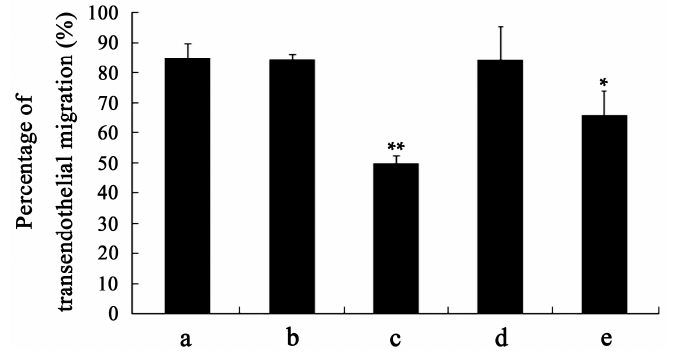
Figure 5. Specificity analysis of the effect of VEGF on mDCs. ( a ) control; ( b ) 50 ng/mL IgG; ( c ) 50 ng/mL VEGF; ( d ) 5 ng/mL TGF- β 1 ; ( e ) 1 ng/mL IL-10. Compared with control group, * p < 0.05, ** p < 0.01.